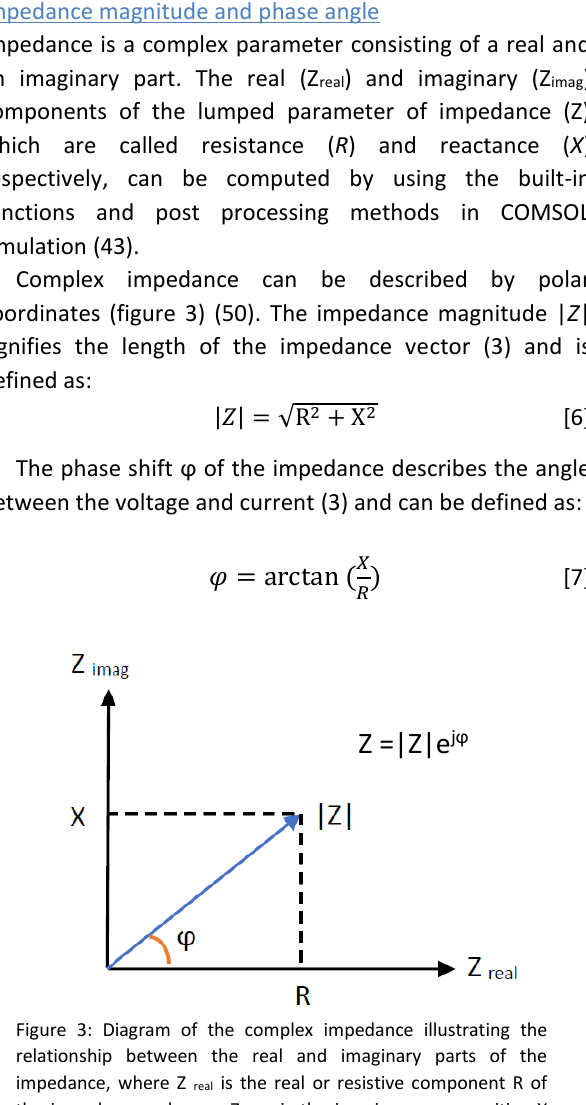
Figure 4: Y-Z Slice plots of a) electrical potential, b) current density, c) sensitivity and d) volume impedance density for the model with 28 surface electrodes simulated with and without the vein at the frequency of 1 MHz where all the surface electrodes were excited as terminals simultaneously (radius of the ground electrode = 0.5 mm, radius of the terminal electrodes = 1 mm).